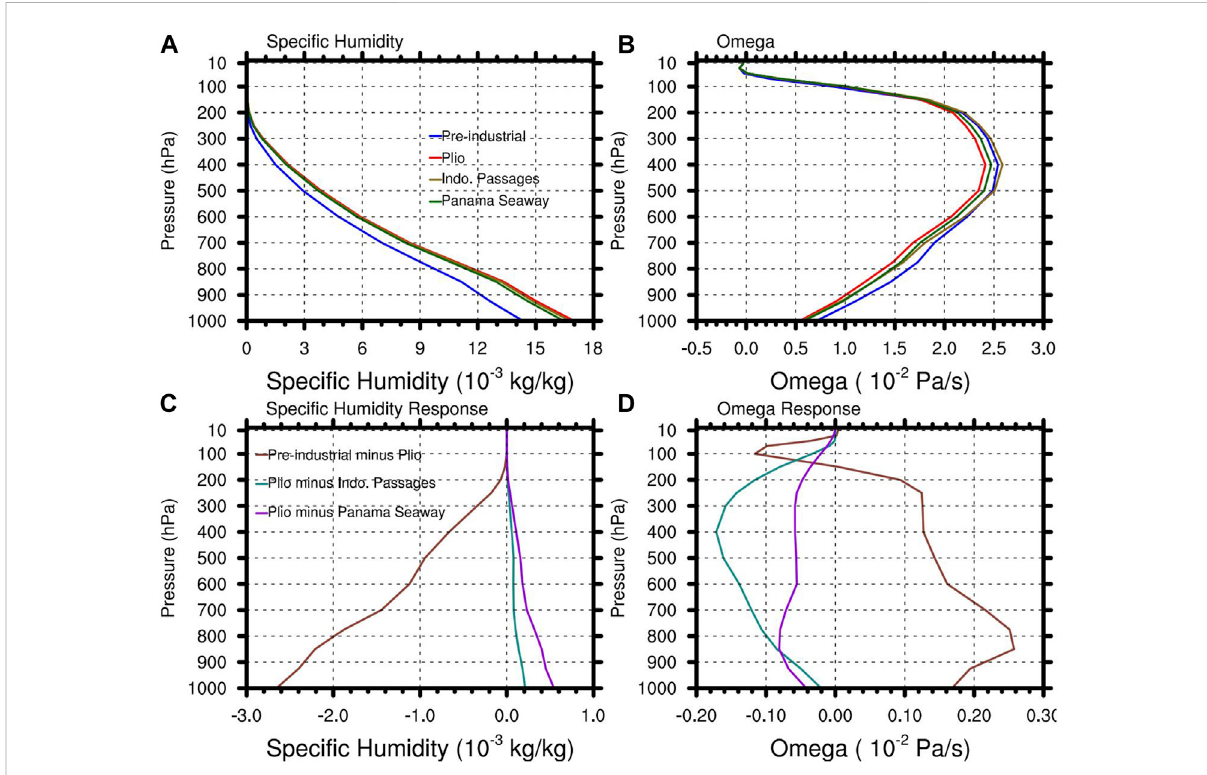
FIGURE 9 Vertical pro fi le of JJA mean (A) speci fi c humidity and (B) vertical pressure velocity averaged over the monsoon region (20 ° N – 40 ° N, 100 ° E – 140 ° E). Vertical pro fi le of response of JJA mean (C) speci fi c humidity and (D) vertical pressure velocity over the monsoon region to CO 2 and seaway changes.